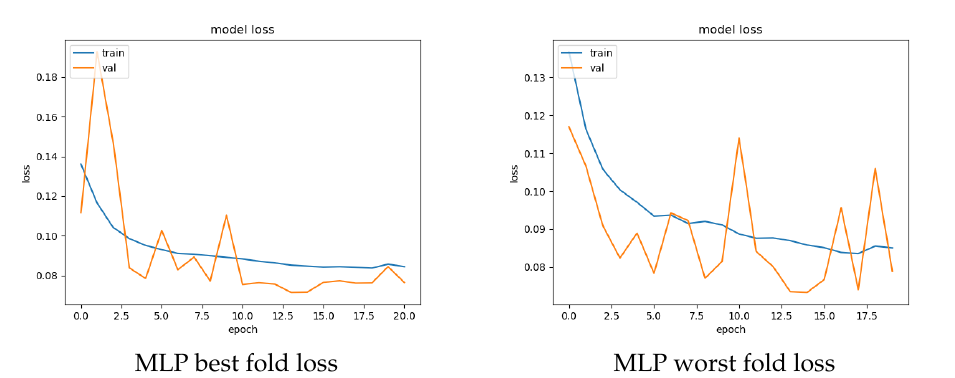
Figure 2. Best performer (MLP) loss per epoch performance for the 802.11 feature set.